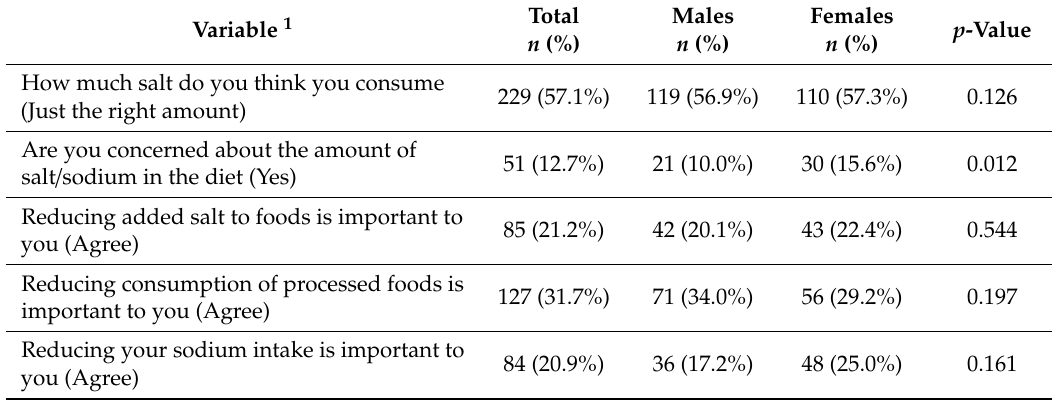
Table 3. Salt-related attitudes among UOS students ( n = 401) by gender.